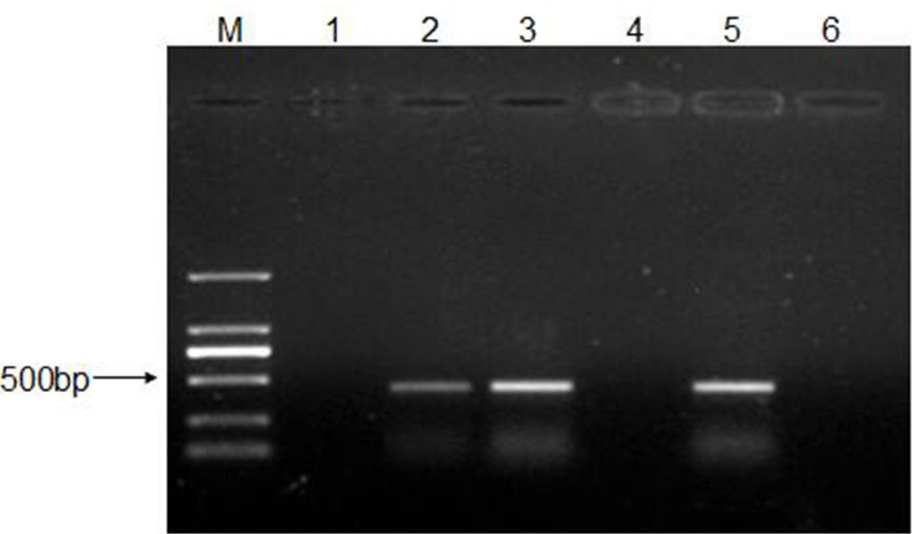
Figure 3. The minimal infective dose for CEV-JL14 to ICR suckling mice. Three-day-old ICR suckling mice were injected with 2 × 10 4 , 2 × 10 6 , and 2 × 10 8 TCID 50 CEV-JL14 by subcutaneous injection, respectively. Mixtures of tissue samples were collected at 5 dpi for RT-PCR to amplify CEV-JL14 genomic fragments. No fragment was observed in mice infected by 2 × 10 4 TCID 50 viruses (Lane 1). Fragments from ICR suckling mice inoculated with 2 × 10 6 (Lane 2) and 2 × 10 8 TCID 50 (Lane 3) CEV-JL14 were amplified with expected size. No fragments were detected in the control groups (Lane 4). Lane 5 and Lane 6 were positive and negative control, respectively. M stands for the DNA ladder.